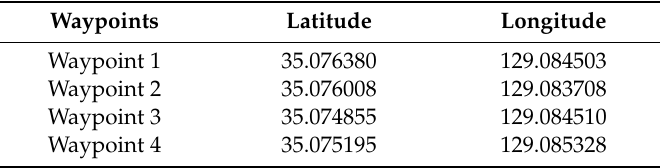
Table 2. Coordinates of waypoints for tracking